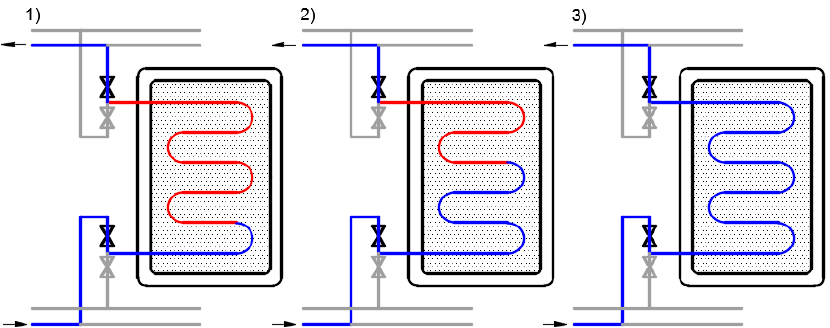
Figure 6. Original control system: Switching the bed from heating to cooling mode. ( 1 ) Switching inlet and outlet valves. ( 2 ) Discharge of the hot water from the adsorber to cooling water cycle. ( 3 ) Valves were switched and water in the heat exchanger replaced.